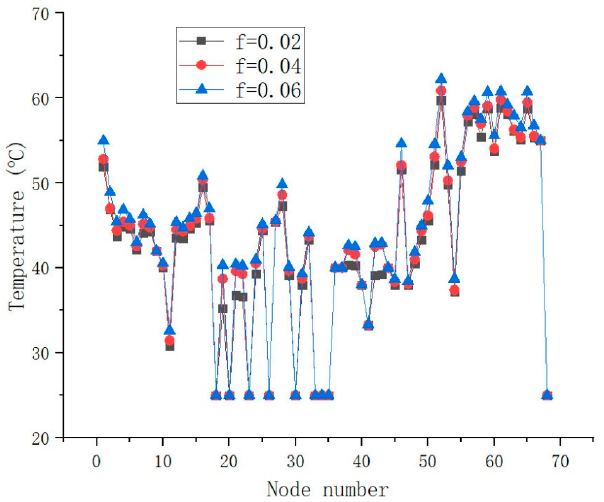
Figure 10. The TFD with the different friction coefficients among teeth.